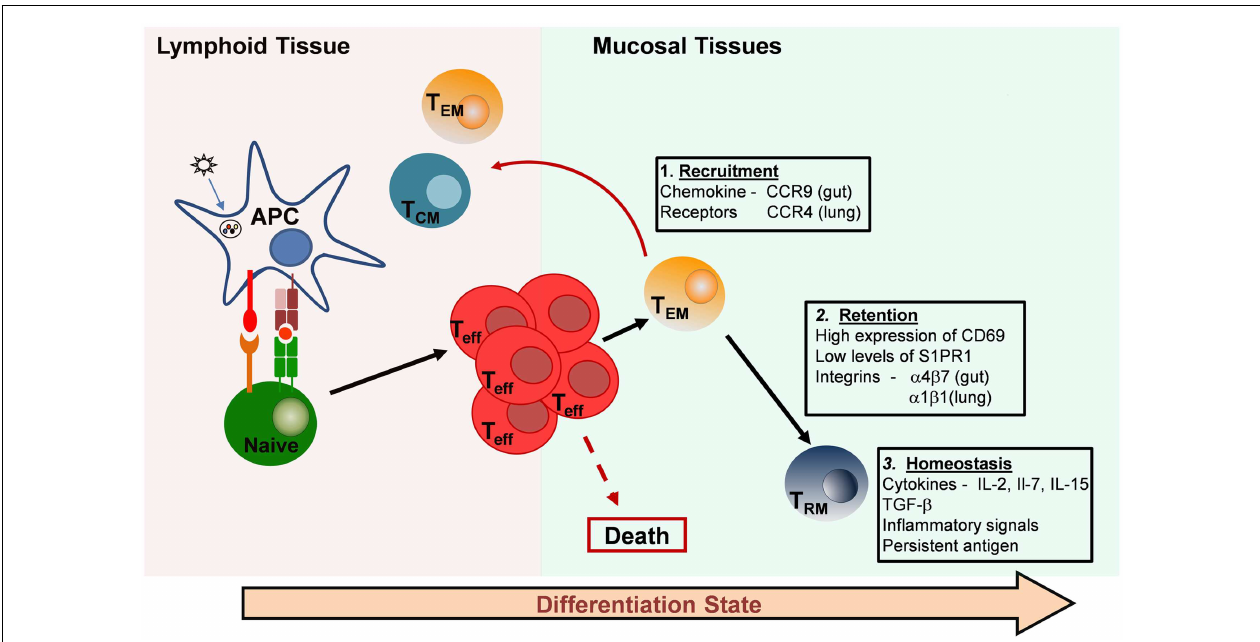
circulate through peripheral tissues and tissue-resident memoryT cells (TRM), which are retained in mucosal tissue sites and take up long-term residence there without recirculating. Retention ofTRM in peripheral tissues is thought to be mediated by the inhibition of egress through S1PR1 and by cell–cell interactions facilitated by integrin expression (Box 2). Maintenance and homeostasis ofTRM in mucosal tissues may depend on pro-survival cytokines, constitutive low-level inflammation, and the persistence of antigen at the site (Box